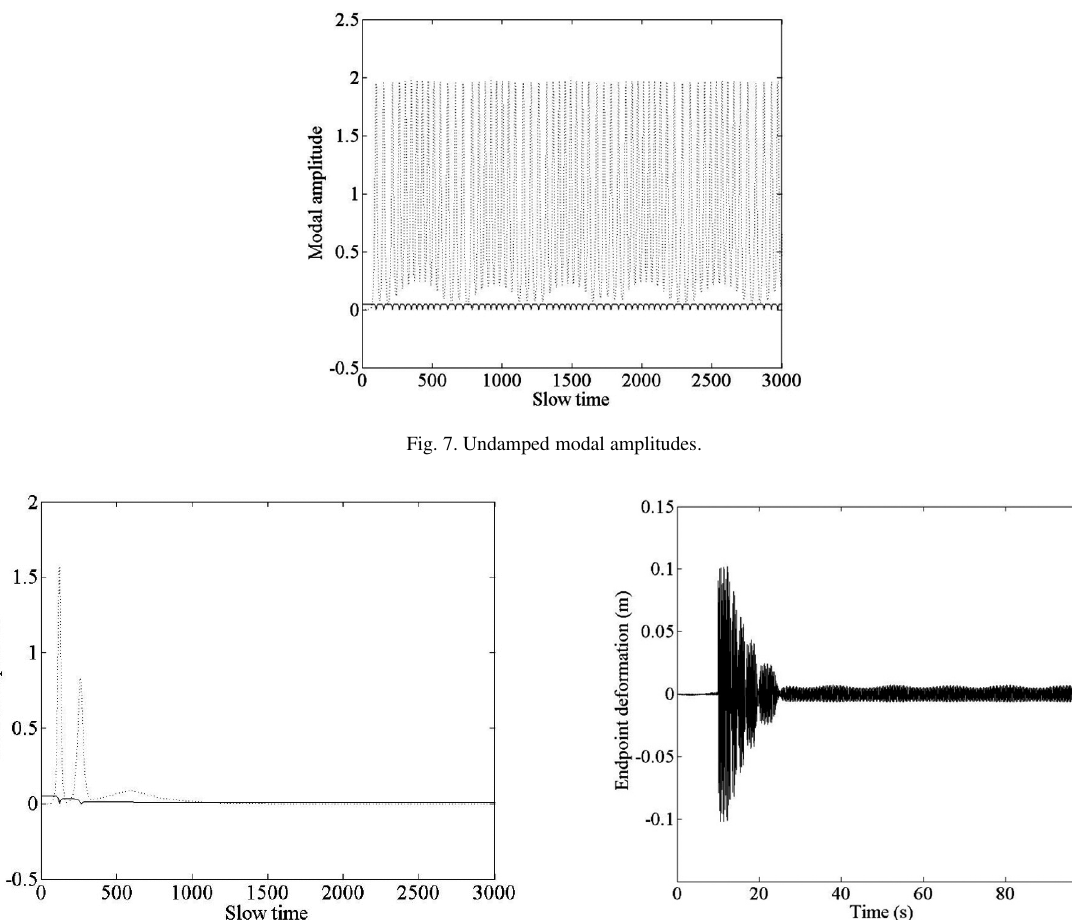
Fig. 8. Damped modal amplitudes. Fig. 9. Endpoint response of the controlled